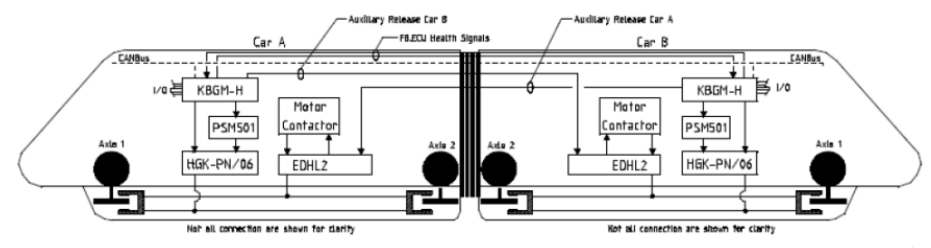
Fig. 3. Brake axle